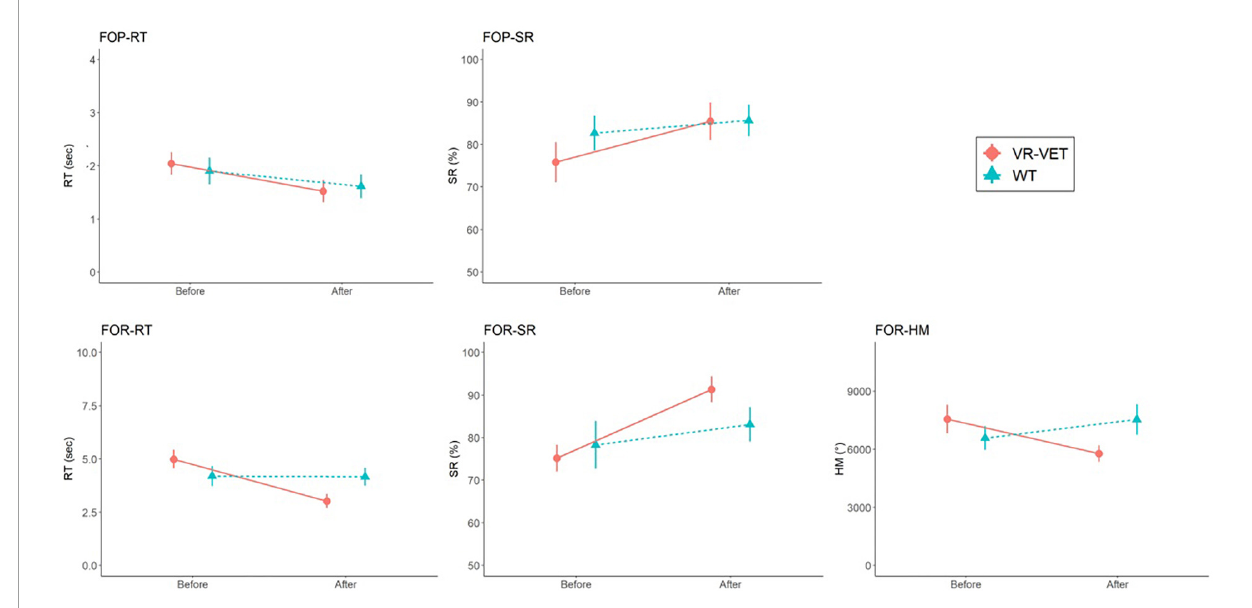
FIGURE3 Comparisons of FOPR test in the whole space between VR-VET and waiting. FOP, field of perception; FOR, field of regard; RT, response time; SR, success rate; HM, head movement; VR-VET, virtual reality-visual exploration therapy.